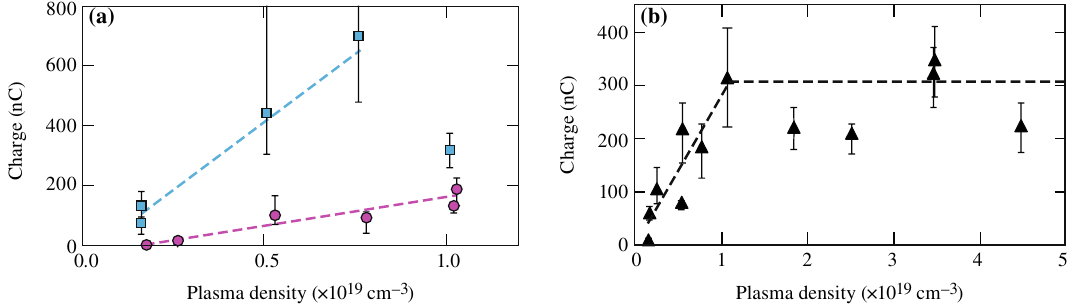
Figure 5. Electron beam charge as a function of plasma density ( a ) up to ~ 1 × 10 19 cm −3 for a 0 ~ 3 (magenta circles) and a 0 (cid:31) 6 (blue squares) for a 6-mm-diameter nozzle and ( b ) over the entire sampled plasma density range for a 0 ~ 5 and a 10-mm-diameter nozzle. The dashed lines are added to guide the